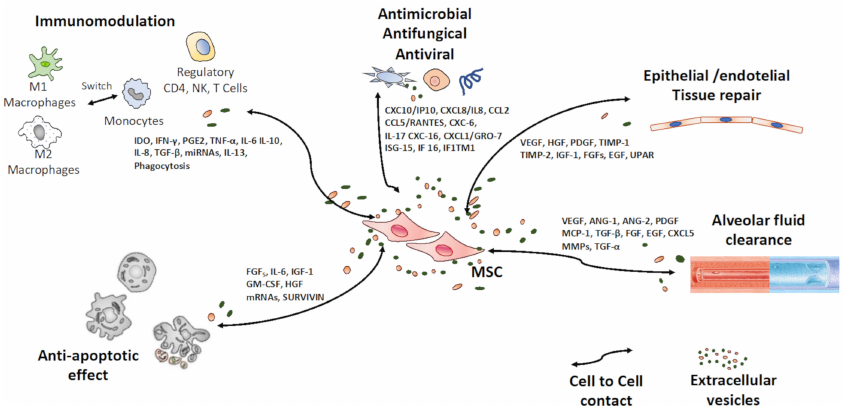
Figure 1. Known and probable therapeutic effects of MSCs on Acute Respiratory Distress Syndrome. Mesenchymal stem cells (MSCs) playing a key role as “traffic controllers” of intercellular signals in different physiological processes through secreted factors (secretome) or by cell-to-cell